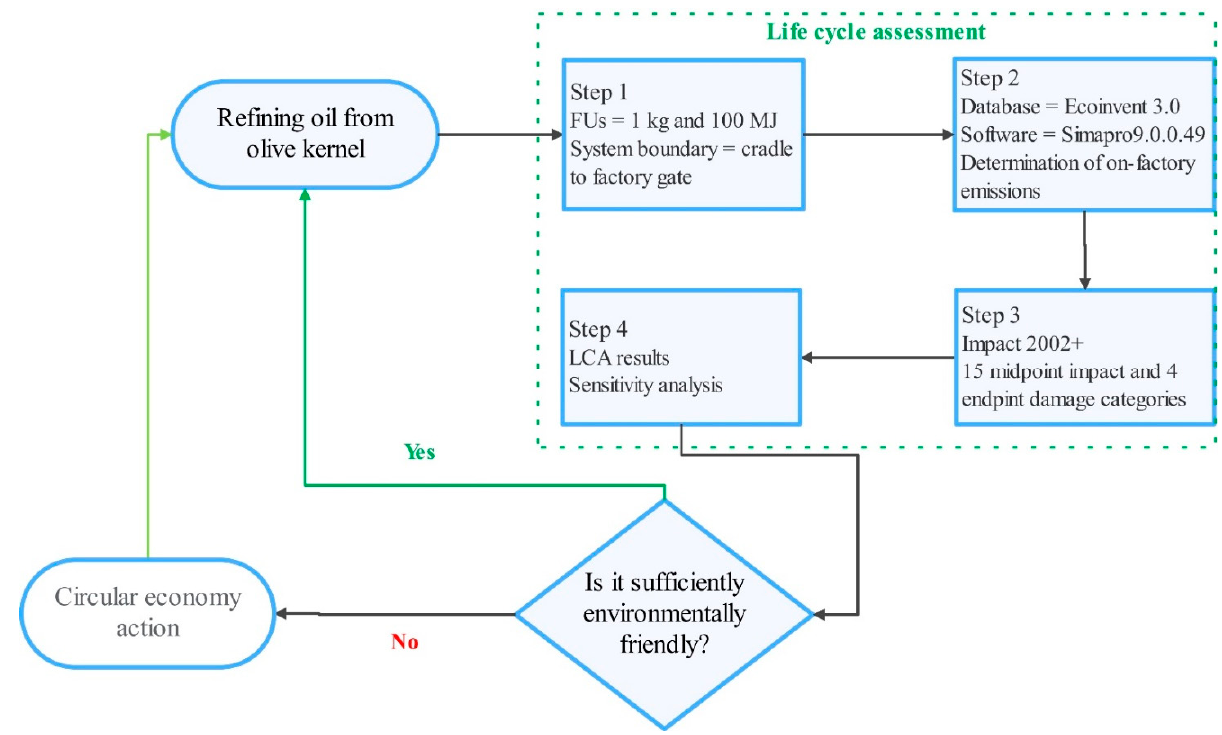
Figure 4. Measuring the circularity of olive kernel oil production using life cycle assessment (LCA) methodology.